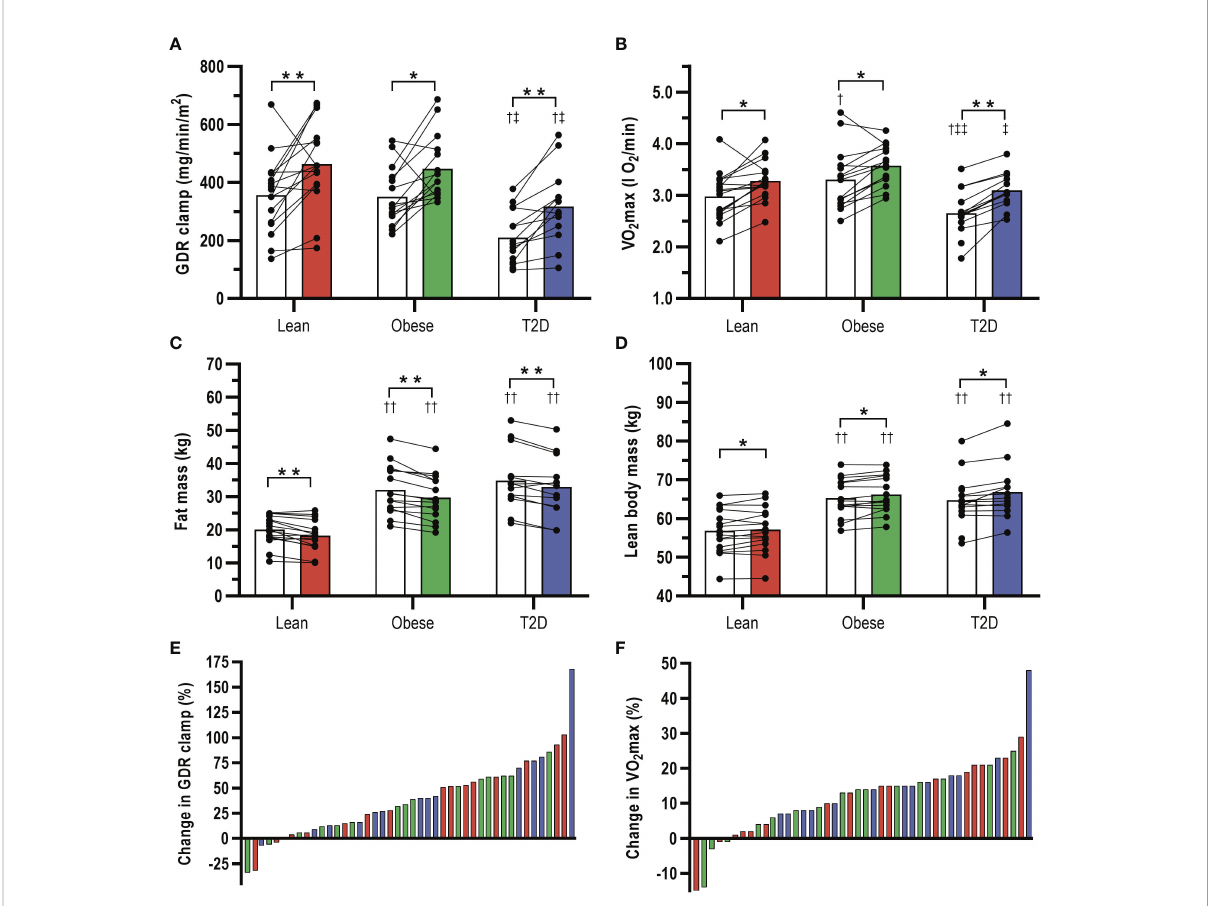
FIGURE 2 Effects of 8-weeks high-intensity interval training (HIIT) combining cycling and rowing on (A) insulin-stimulated glucose disposal rates (GDR clamp), (B) VO 2 max, (C) total fat mass, and (D) total lean body mass in patients with type 2 diabetes (T2D) and glucose tolerant obese and lean individuals. White bars show pre-training data and colored bars post-training data. (E, F) interindividual variability in the changes in GDR clamp and VO 2 max in response to HIIT in T2D (blue bars), obese (grey bars) and lean (red bars). Data are means ± SEM. * p <0.05 and ** p <0.001 vs. pre-training, † p <0.05 and †† p <0.001 vs. lean, ‡ p <0.05 and ‡‡ p <0.001 vs.